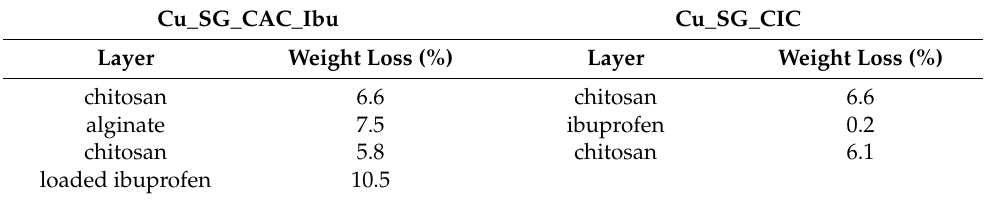
Figure 4. TGA first derivative for each loading step of ( A ) Cu_SG_CAC_Ibu and ( B ) Cu_SG_CIC, in the temperature range considered for the weight loss calculation. Table 2. Weight loss percentages associated with each deposited layer and ibuprofen